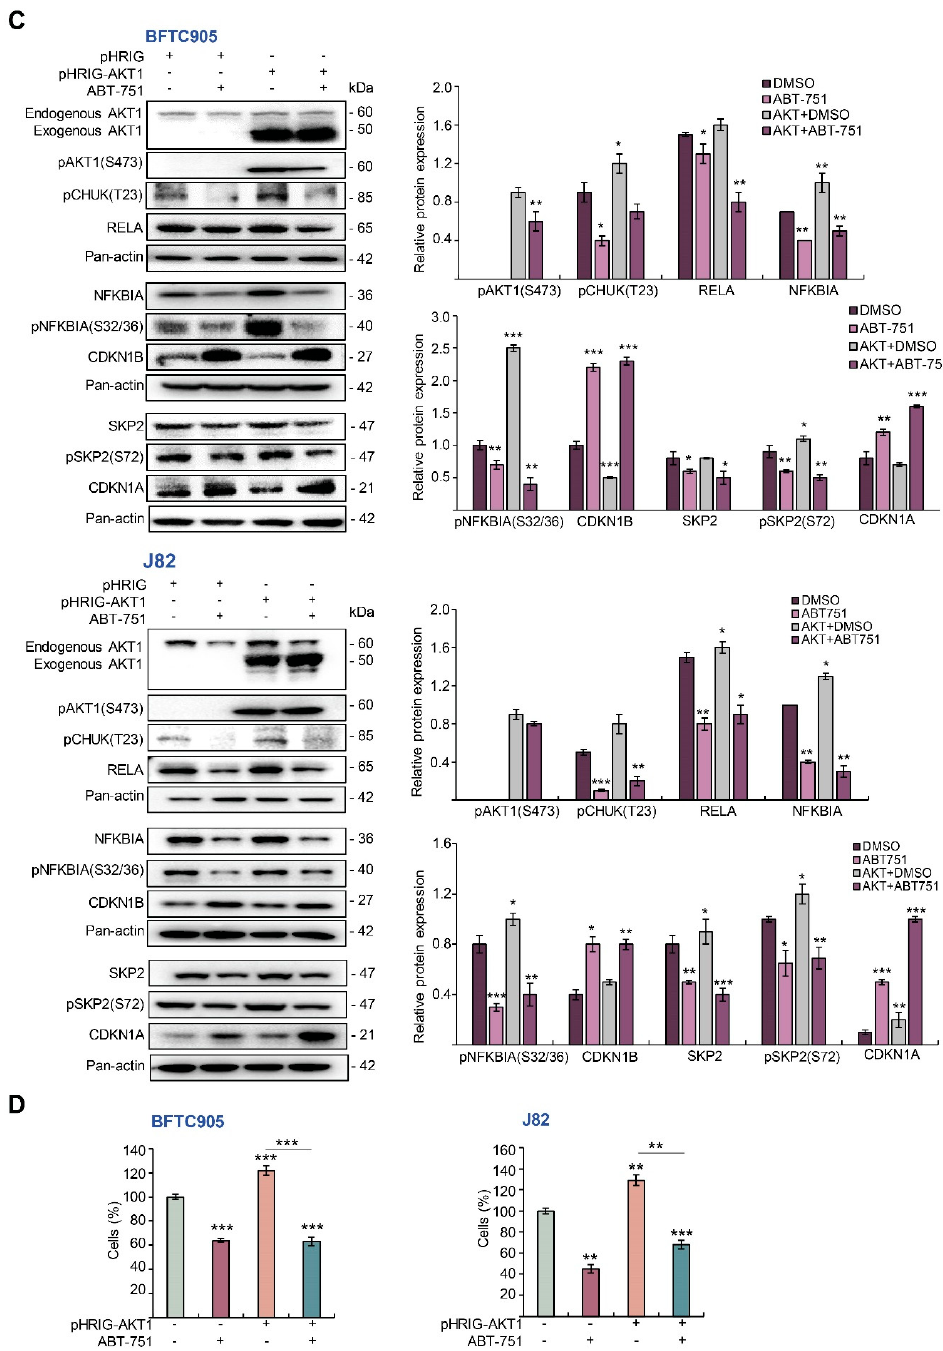
Figure 5. ABT-751 induces cytostasis by downregulation of stable/phospho-SKP2 proteins through the inhibition of the PI3K–AKT signaling pathway in UBUC-derived cell lines. BFTC905 and J82 cells were transfected with pHTC-HaloTag (as a control) or pSKP2-HaloTag. After 24 h, the transfected cells were treated with the indicated concentration of ABT-751 (BFTC905, 0.6 µ M and J82, 0.7 µ M). Next, ( A ) the expression levels of pSKP2(S72), pSKP2(S64), CDKN1A, and CDKN1B proteins were investigated by immunoblots and ( B ) a cell proliferation assay was conducted. BFTC905 and J82 cells were transfected with pHRIG (control) or pHRIG-AKT1. After 24 h, the transfected cells were treated with the indicated concentration of ABT-751 (BFTC905, 0.6 µ M and J82, 0.7 µ M), and ( C ) the expression levels of various AKT–CHUK–NFKBIA– NFKB signaling pathway-associated proteins were measured by immunoblots, and a cell proliferation assay was conducted ( D ). Relative protein levels were quantified using ImageJ software. The results are expressed as the means ± SD. Pan-actin served as the loading control in each gel for immunoblot analysis. Statistical significance: * p < 0.05, ** p < 0.01, *** p <